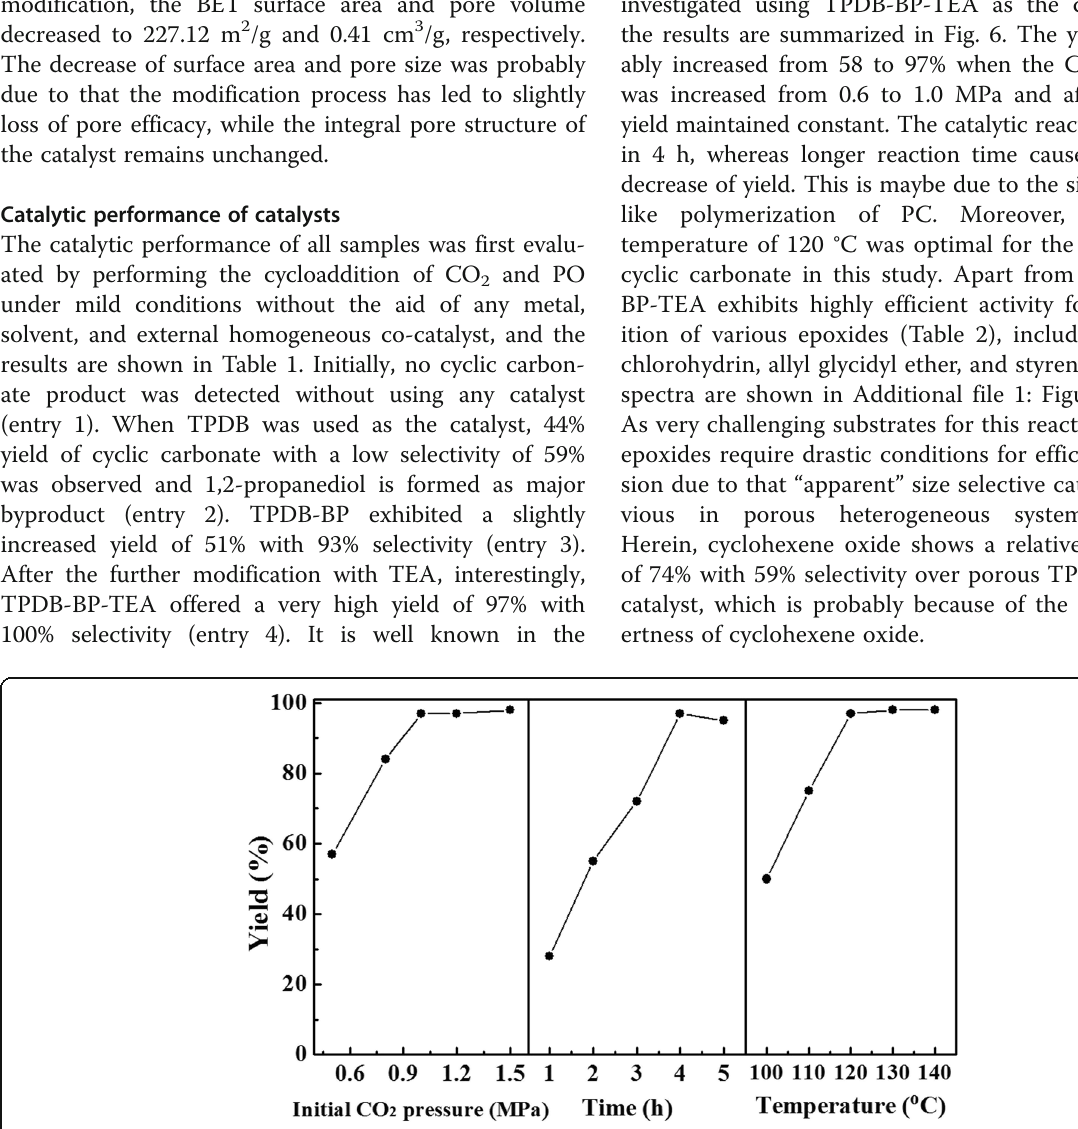
Fig. 6 Influence of reaction parameters on the cycloaddition reaction of CO 2 with propylene oxide. The yield remarkably increased from 58 to 97% when the CO 2 pressure was increased from 0.6 to 1.0 MPa and after that the yield maintained constant. The catalytic reaction finished in 4 h, whereas longer reaction time caused a slightly decrease of yield. This is maybe due to the side reactions like polymerization of PC. The optimal reaction temperature was 120 °C